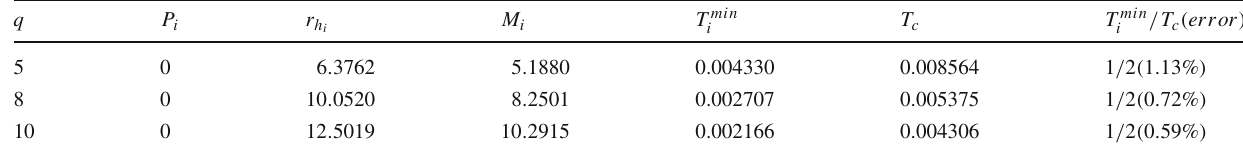
Table 1 The related quantities for minimal inversion temperature with the change of charge. α is set to be